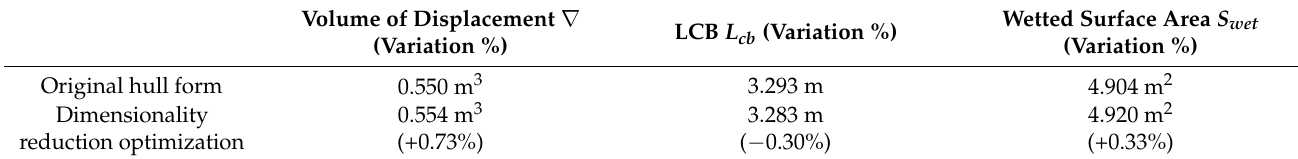
Table 11. Comparison of hydrostatic parameters of dimensionality reduction optimization.